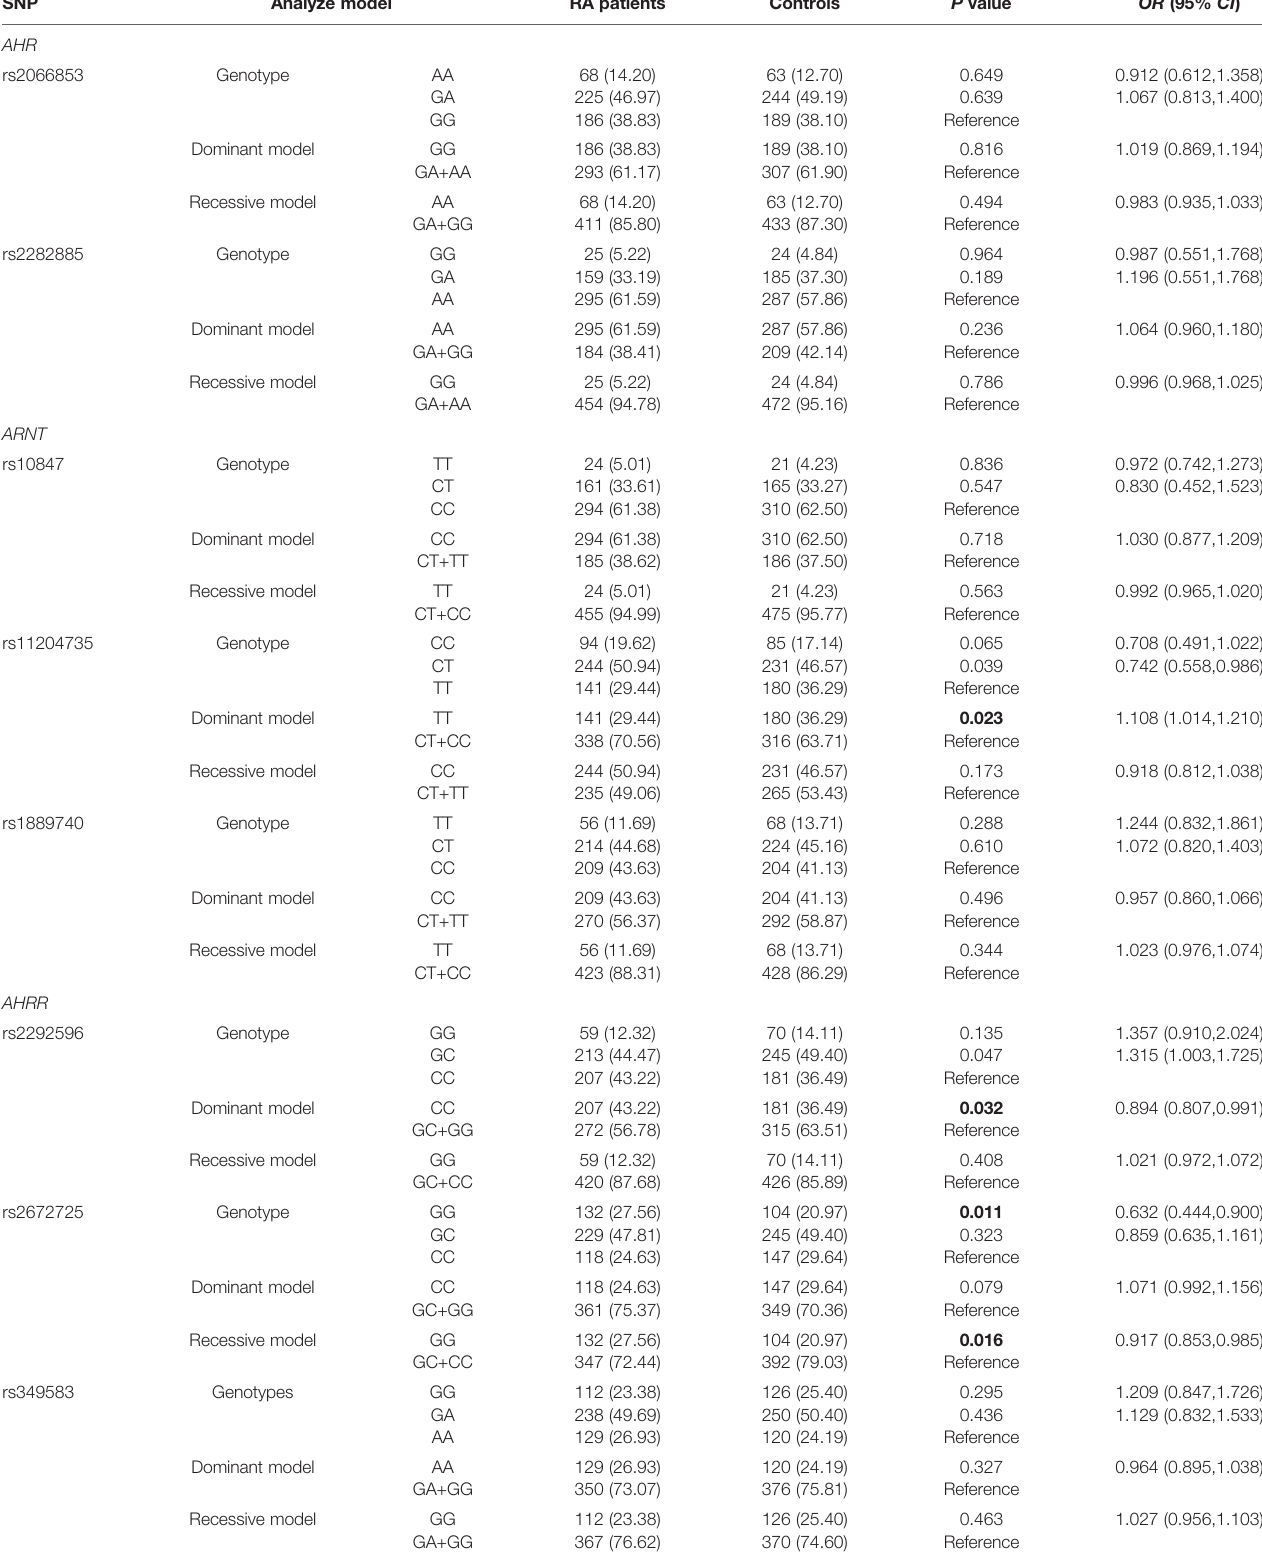
TABLE 2 | Genotype frequencies of AHR, ARNT, AHRR genes in RA patients and